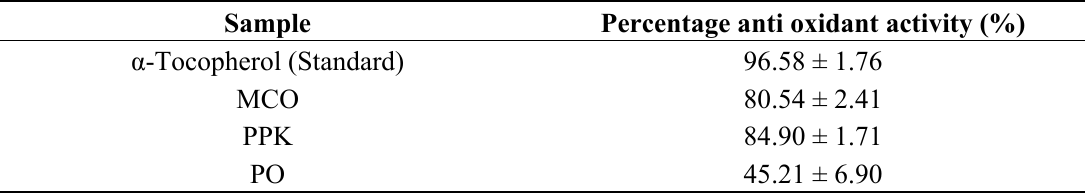
Table 3 . Total anti-oxidant activity of polypeptide-k and oil from Momordica